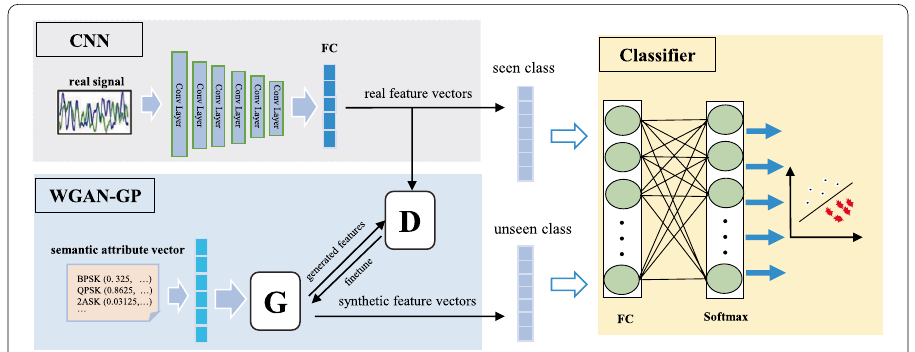
Fig. 4 The network architecture of SigZSLNet. WGAN-GP can generate the feature data of the unseen (missing) classes, D is the discriminator, and G is the generator. The classifier consists of a fully connected layer with the neuron number 128 and a softmax layer with the class 7